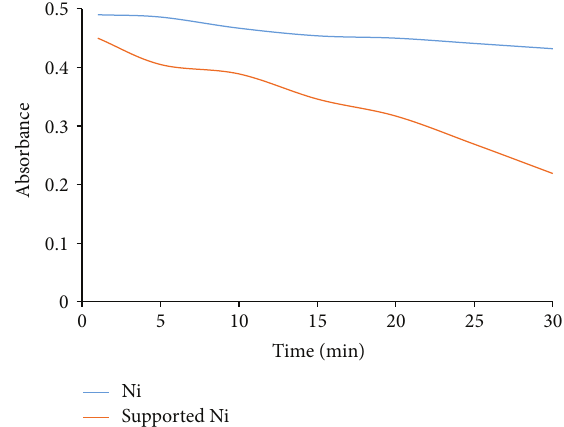
Figure 4: Absorbance of methylene blue during oxidation by H 2 O 2 in the presence of Ni, catalyst, as function of time.